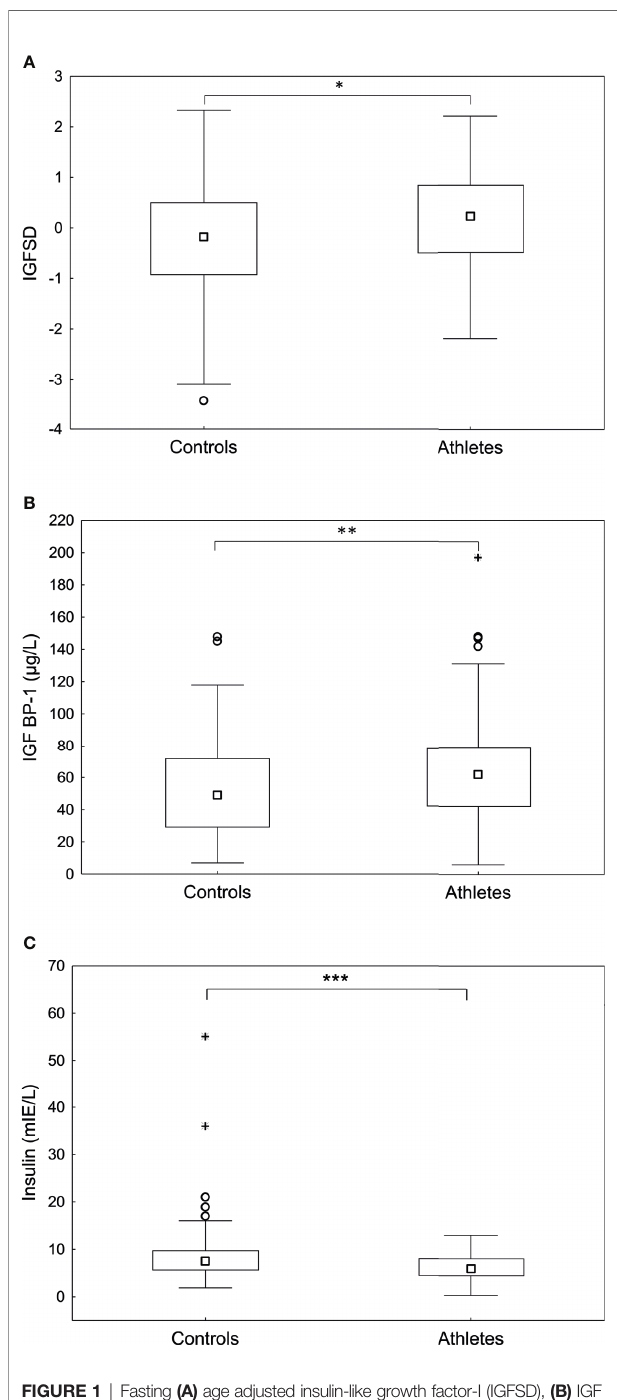
FIGURE 1 | Fasting (A) age adjusted insulin-like growth factor-I (IGFSD), (B) IGF binding protein- 1 (IGFBP-1) and (C) insulin levels in controls and athletes. The athletes demonstrated signi fi cantly higher IGFSD and IGFBP-1 and signi fi cantly lower insulin levels compared to controls. Box plots showing median, Q25-75, total range, outliers and extremes. *p < 0.05, **p < 0.01, ***p <